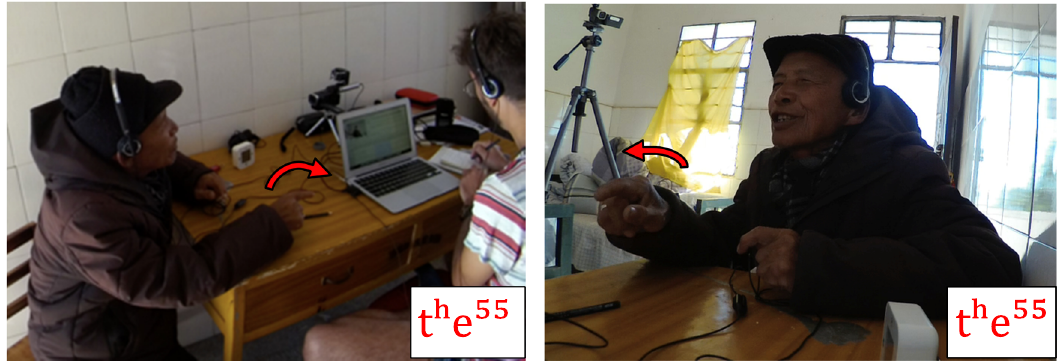
Figure 16: Repeated puncturing gesture towards the addressee obtains twice. This is co - timed with addressee deictics bolded in Example 26. Same frame captured by a lateral and a frontal camera,